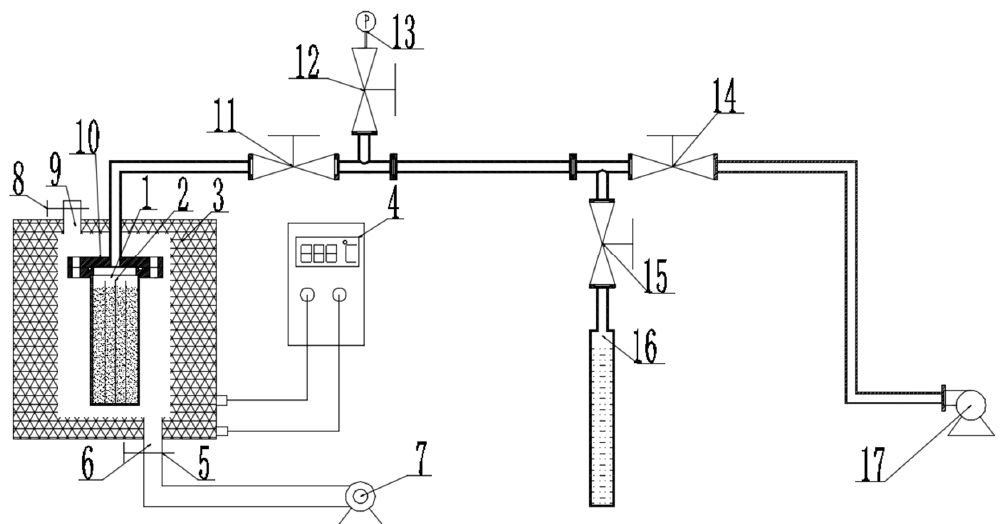
Figure 2. Schematic diagram of adsorbent performance testing device. 1—adsorbent bed, 2—absorbent